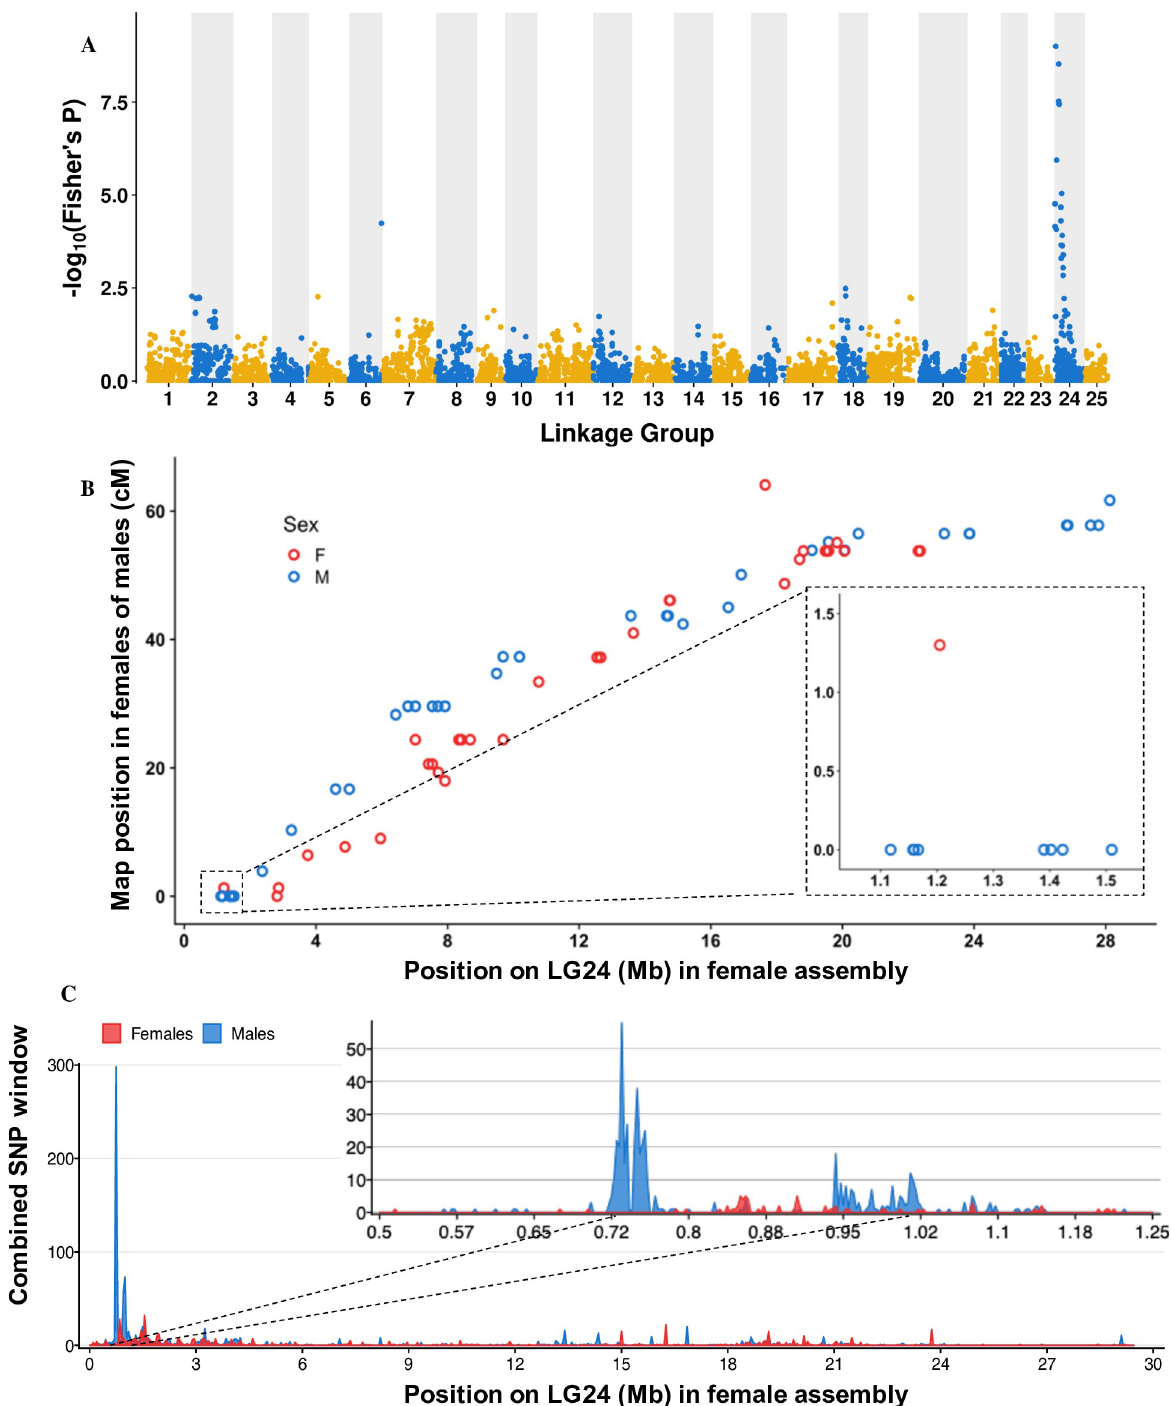
Fig 2. RAD-Seq and pool-seq analysis on a female reference genome of E . lucius (GenBank assembly accession: GCA_004634155.1) locates a small sex locus to the sub-telomeric region of Linkage group (LG)24. A : The log 10 of p-values from the Fisher’s exact test between each marker and sex phenotype is mapped against the linkage group (LG) to which they belong. Linkage group 24 showed a concentration of markers significantly associated with sex phenotype. B: Genetic map distance of RAD-Seq markers on LG 24 plotted against their physical position in LG24 for males and females. Recombination is observed along the entire length of LG24 in females and for most male markers except a group aligned to a region between 1.1 mb to 1.5 Mb on the physical map that shows no recombination with the sex locus mapped to 0 cM on the genetic map. Black dotted-line box highlights the group of male markers that shows no recombination with the sex locus with a zoomed-in view on the side. C :